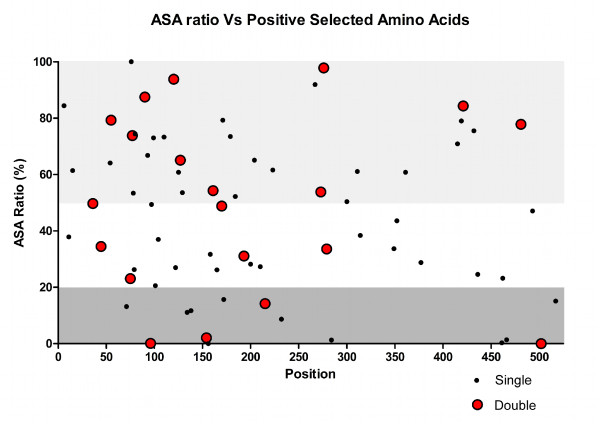
Exposure of residues to the exterior of the MEPE protein. Plot of the ASA ratio calculated between the side-chain and the 'random coil' value of each residue. Sites with a ratio above 50% (yellow box) are considered to be exposed to the outside of the protein whereas sites under 20% are considered to be buried (pink box). Sites under positive selection in both gene and protein-level analyses are marked with the red dots (double) and sites showing selection in at least one of the analysis is represented as black dots (single).